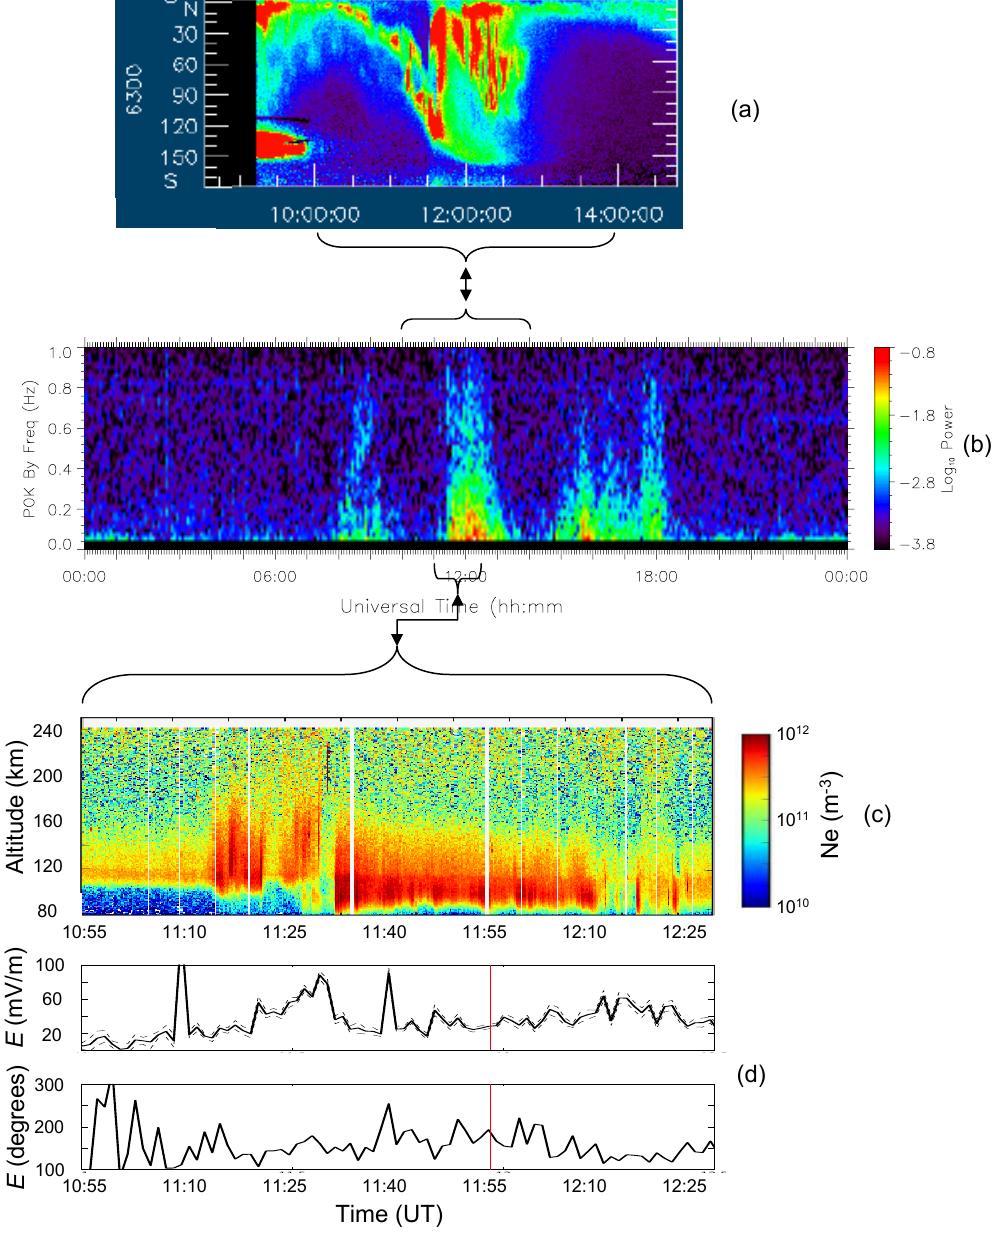
Fig. 1. Geophysical context: (a) Keogram from all sky image, (b) spectrogram of magnetometer fluctuation, (c) altitude/time/density from PFISR, (d) electric field from PFISR, with vertical red line showing the time of the pulsations.